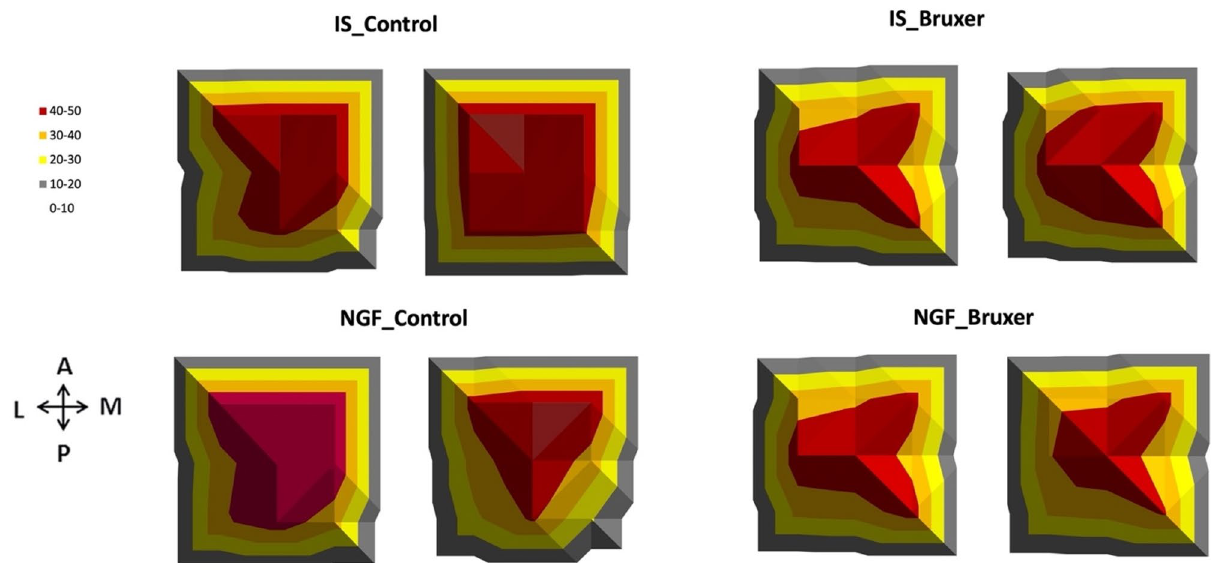
Figure 2. Masseter MEP corticomotor map area elicited by TMS of multiple scalp sites arranged in a one × 1 cm 2 grid at 120% MT before (baseline) and 72 h after (post ‐ injection) the intramuscular administration of NGF and IS in the bruxer and control participants. Arrows indicate directions (anterior, posterior, medial, and lateral). Motor threshold (MT); motor evoked potential (MEP); nerve growth factor (NGF); isotonic saline (IS); transcranial magnetic stimulation